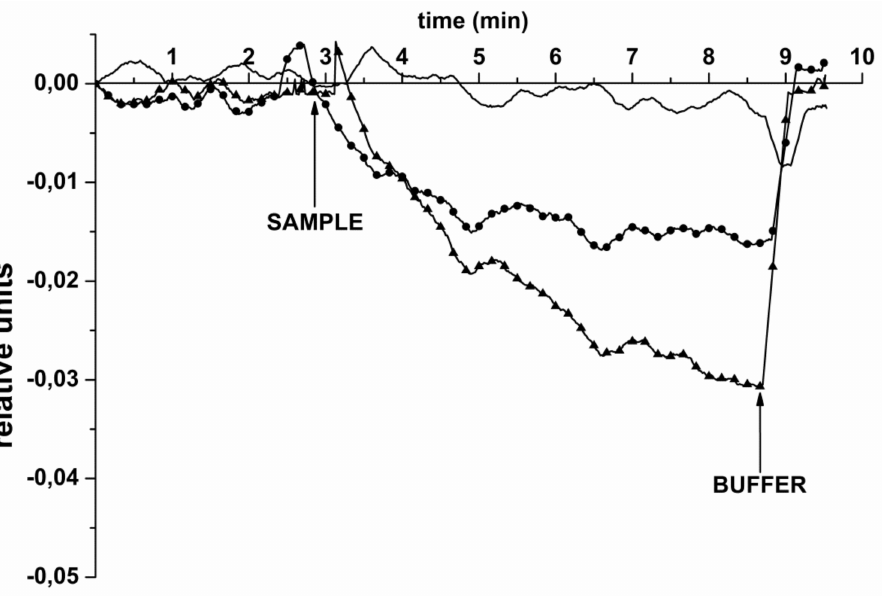
Figure 6. Typical sensograms obtained during the SOI-NR-based detection of circRNA, isolated from: the plasma of a healthy volunteer (control 1; no marker); the plasma of a prostatic hyperplasia patient (circles, • ); the plasma of a glioma patient (sample No. 001; triangles, (cid:78) ). Experimental conditions: 1 mM potassium phosphate buffer; Vg 50 V; Vds 0.1 V; total volume of the analyzed solution in the cell was 107 µ L. The sensor surface was sensitized with oDNA probe #26. The time points of the addition of sample (circRNA solutions) into the cell, and washing with 1 mM fresh potassium phosphate buffer are indicated by